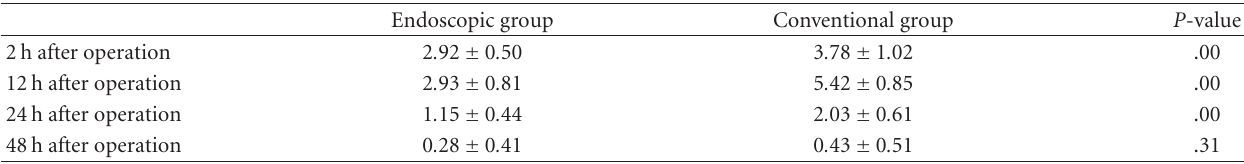
Table 2: VAS after